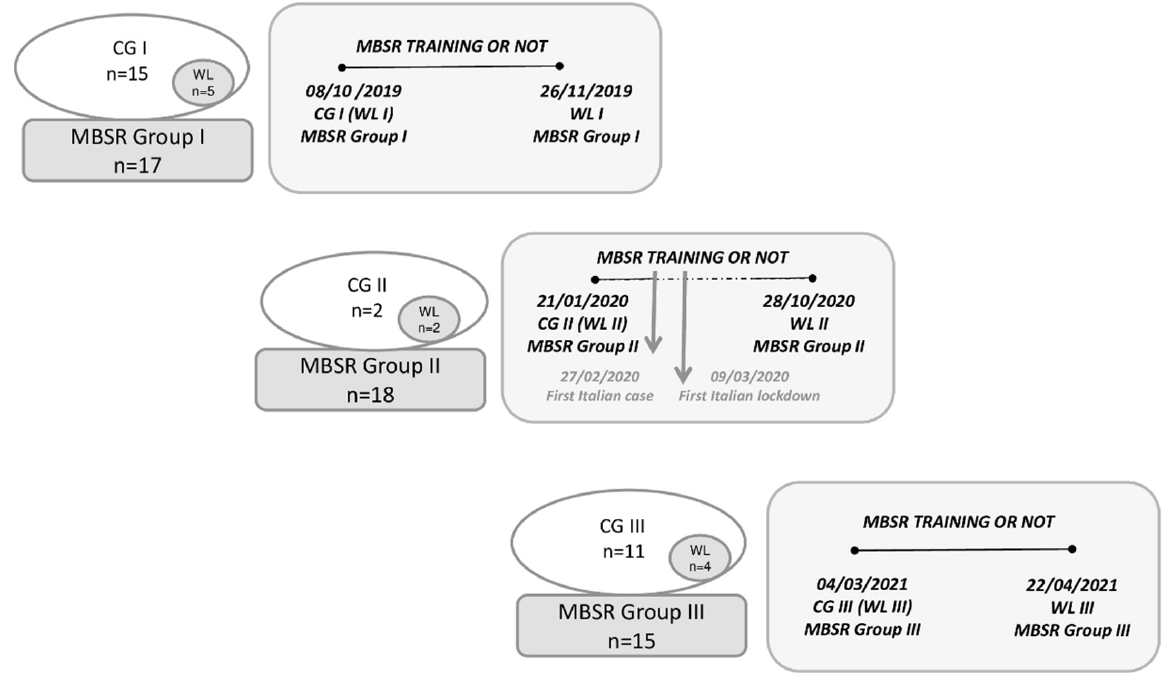
Figure 1. Timeline of the study, representing the different experimental and waiting list groups along with study measures. Abbreviations: CG: control group; MBSR: Mindfulness-Based Stress Reduction course; WL: waiting list.